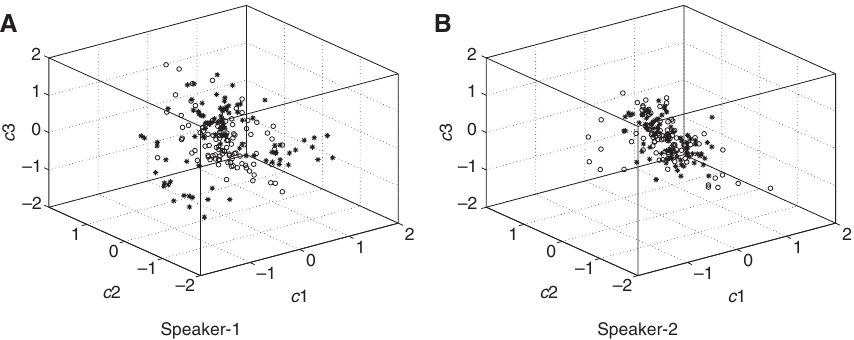
Figure 3: Distribution of Features for 1 s of Speech Data for Two Different Languages (o – English and * –